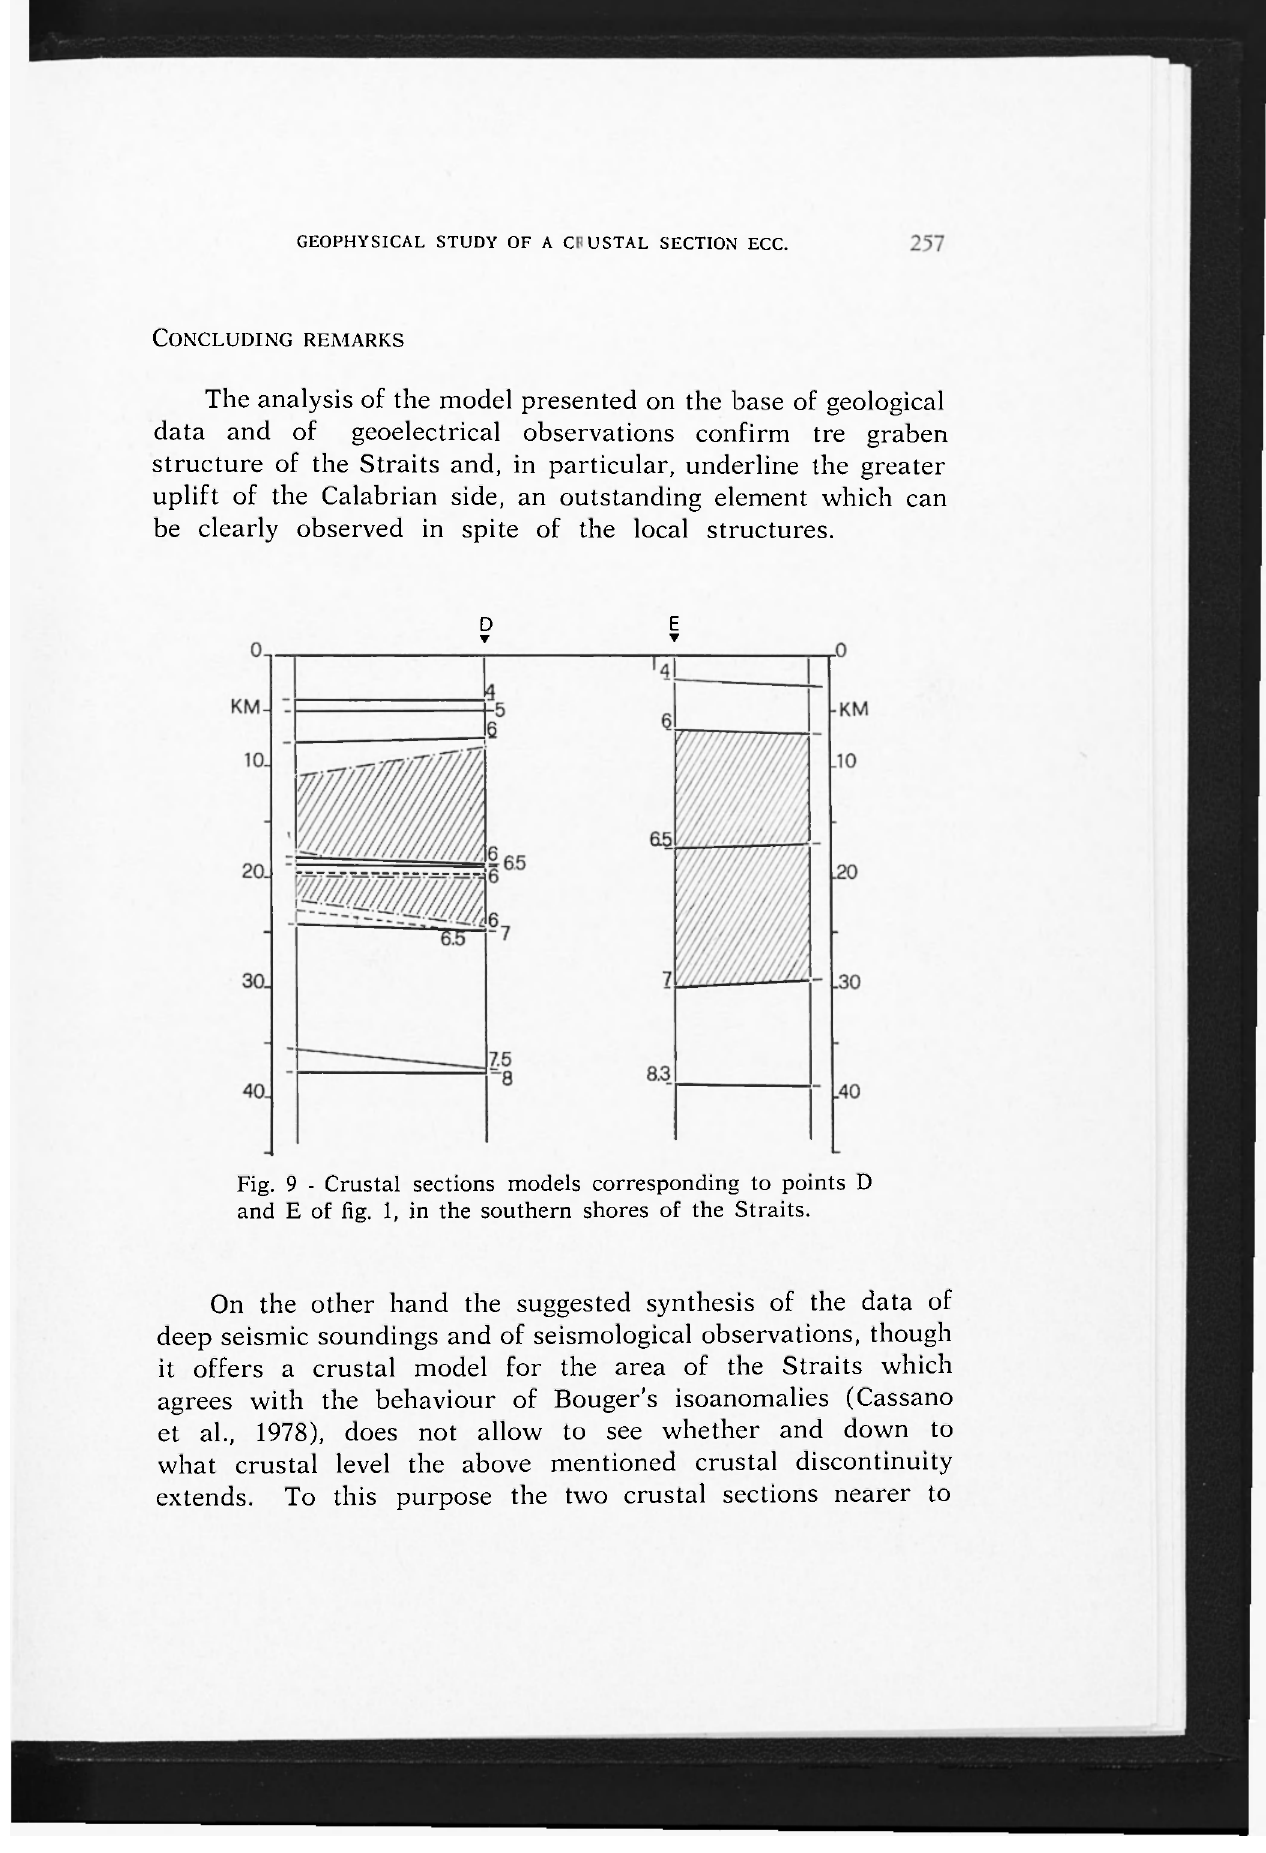
Fig. 9 - Crustal sections models corresponding to points D and E of fig. 1, in the southern shores of the